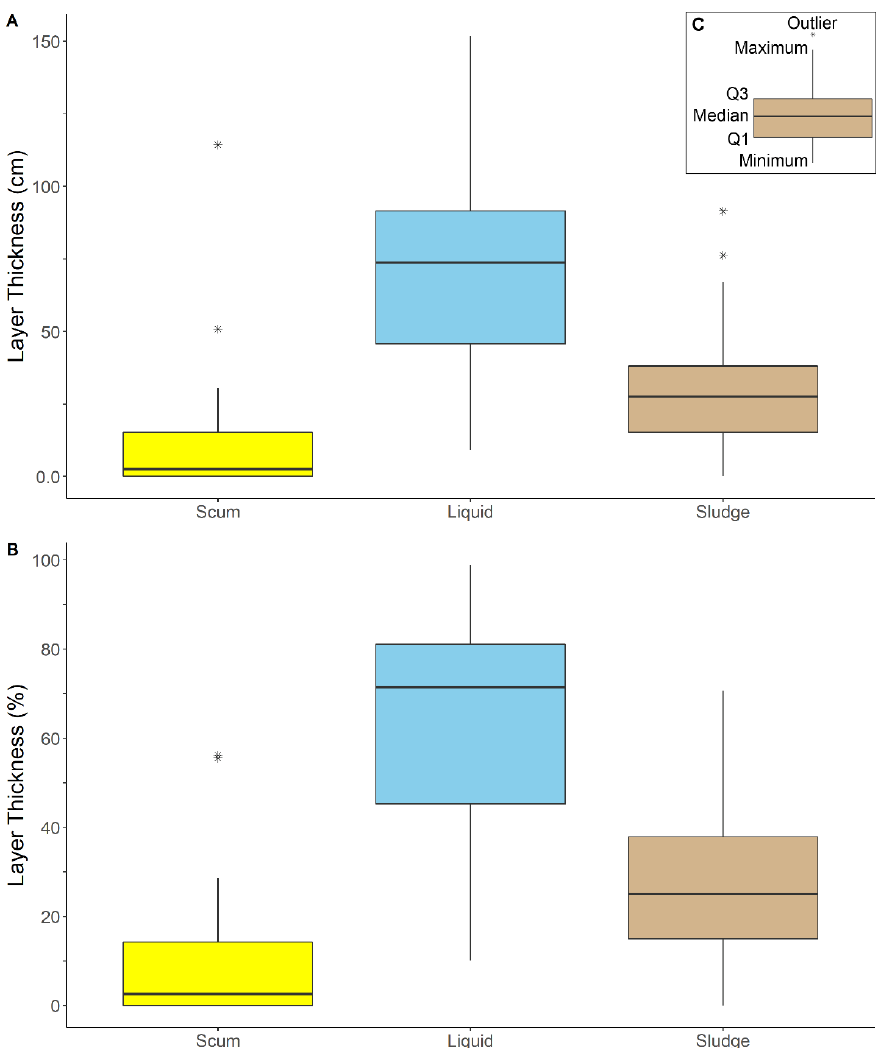
Figure 2. Boxplots of scum, liquid, and sludge with measured thickness (cm, A ) and relative percentage (%, B ) for each septage layer. The inset boxplot ( C ) displays and defines the summary statistics provided by the boxplots. The lower limit denotes the minimum value, the bottom border of the box denotes the first quartile (Q1), the bar denotes the median (or second quartile), the top border of the box denotes the third quartile (Q3), and the upper limit denotes the maximum value. The area between Q1 and Q3 is the interquartile range (IQR). The lower limit is calculated by subtracting the Q1 value from the product of 1.5 and the IQR, whereas the upper limit is calculated by adding the Q3 value to the product of 1.5 and the IQR. Asterisks (*) denote observations that fell outside the lower and upper limits and show the true minimum or maximum value for the range.